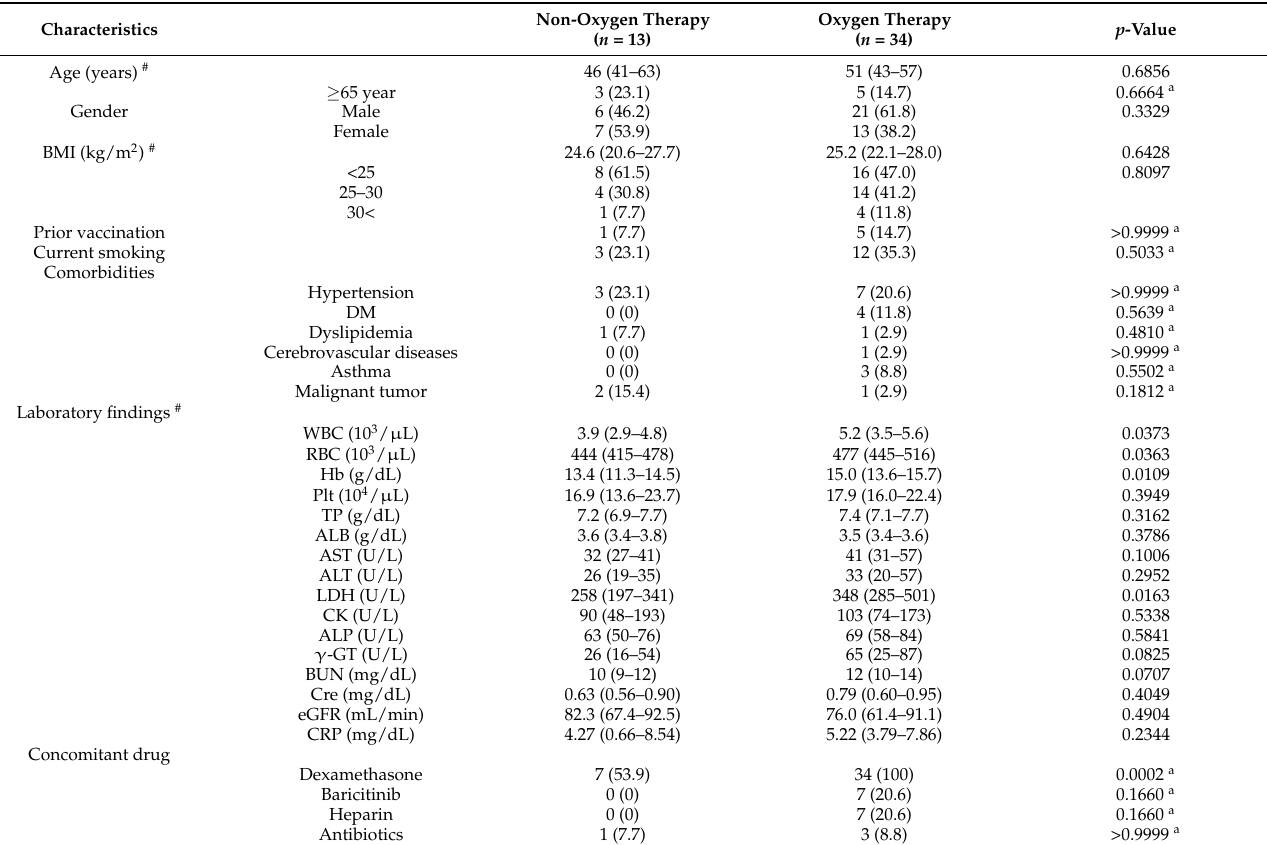
Table 1. Comparisons of clinical characteristics between non-oxygen therapy group ( n = 13) and oxygen therapy group ( n =